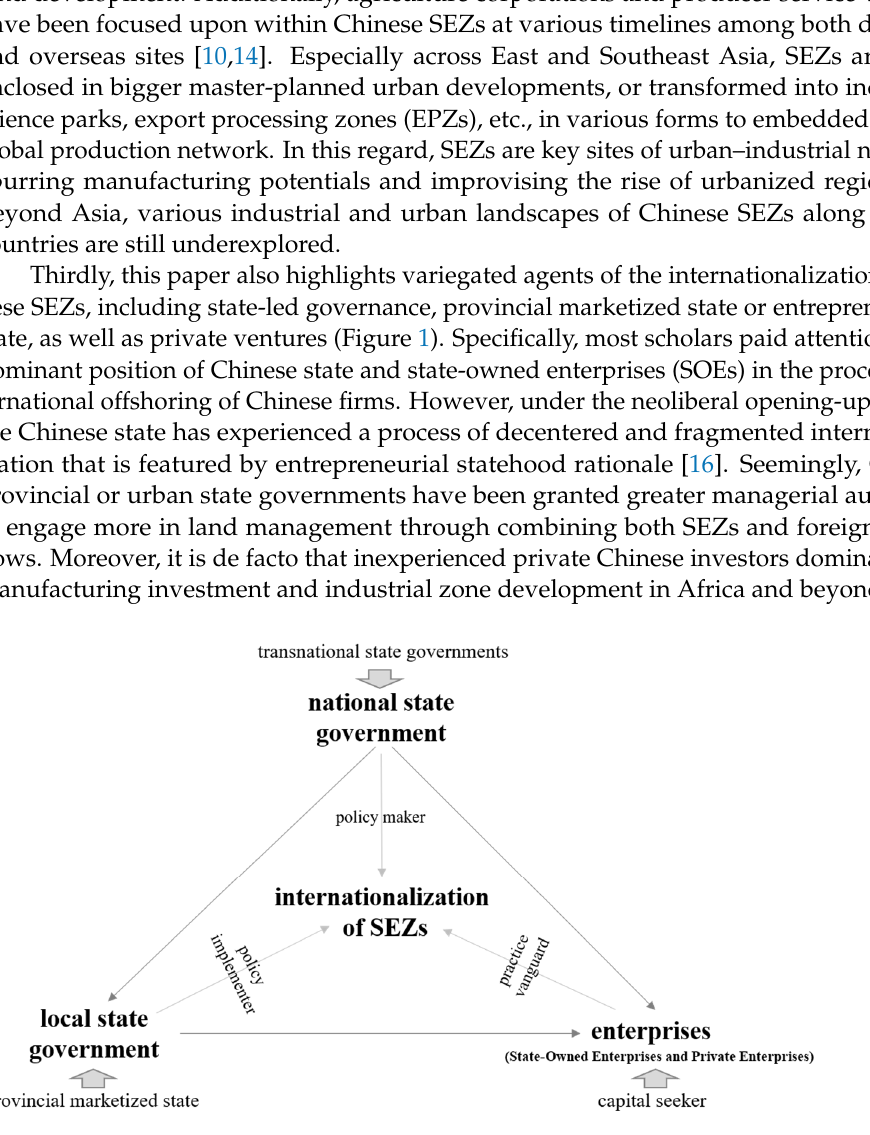
Figure 1. Main actors of the internationalization of Chinese SEZs.